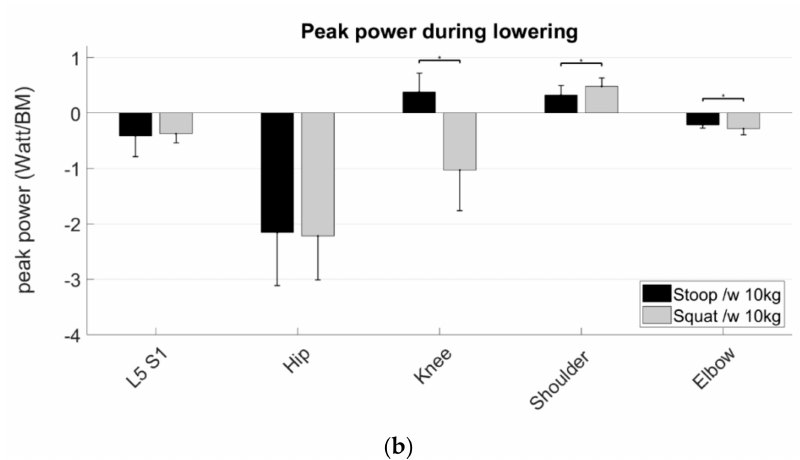
Figure A5. Peak power normalized to body mass during the two di ff erent lifting techniques (stoop and squat) with the 10 kg box. Statistical significant di ff erences ( α < 0.05) between the handling phases are not indicated, as handling phase a ff ected peak power by inverting power generation and absorption in all conditions. Statistical meaningful di ff erences between technique and loads are indicated with one dot. Error bars indicate standard deviations. ( a ) Peak power during the lifting phase in the five di ff erent joints (L5S1, hip, knee, shoulder and elbow); ( b ) peak power during the lowering phase in the five di ff erent joints. In the 10 kg condition only, peak power absorption and generation in the shoulder were significantly higher during the squat than during the stoop, which is in contrast to the 40%